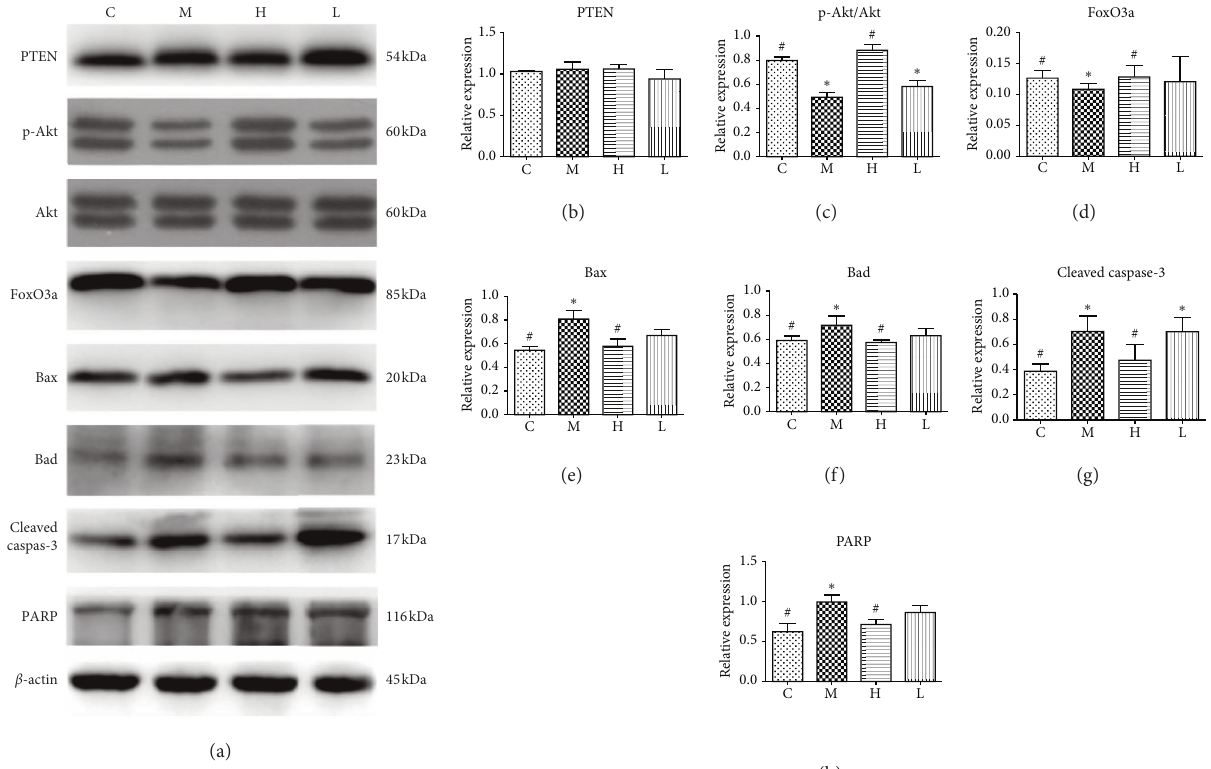
Figure 6: Western blot analysis of the protein expression of AKTsignaling molecules in rat ovaries of each group. ∗ : significant compared to group (C) ( P < 0 . 05 ) ; #: significant compared to group (M) ( P < 0 . 05 )